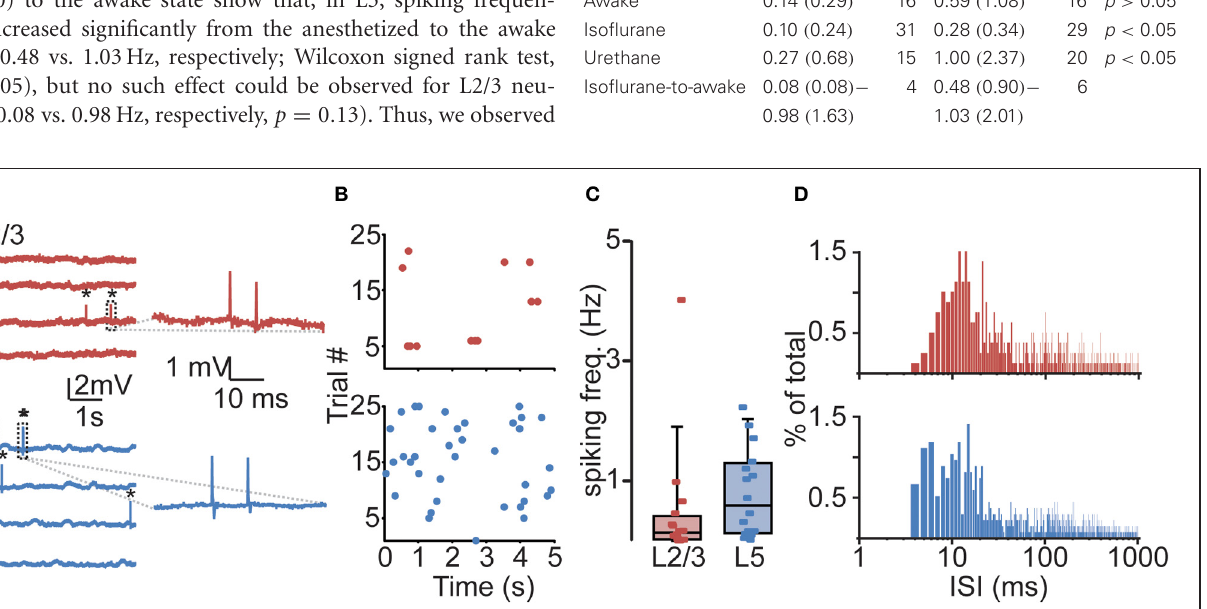
FIGURE 2 | Sparse and irregular action potential (AP) spiking activity in prelimbic PFC of awake rats. (A) Representative juxtasomal recordings of individual L2/3 and L5 neurons recorded during wakefulness. APs are indicated by black asterisks. Right panel shows magnification of area indicated in dashed box. (B) Raster plots of the neurons shown in (A) showing all spikes observed during a 125s recording. (C) Box plot showing